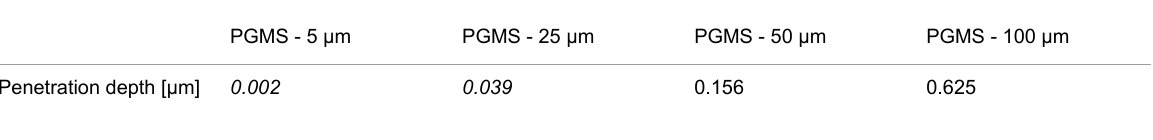
Table 4: Penetration depths of the glass ball into the periodical groove-like polymer surface – PGMS at different pitch dimensions based on geometry only. The calculated values, which lay beyond the system’s resolution in vertical direction (cantilever deflection in vertical direction, smaller 50 nm), are shown in